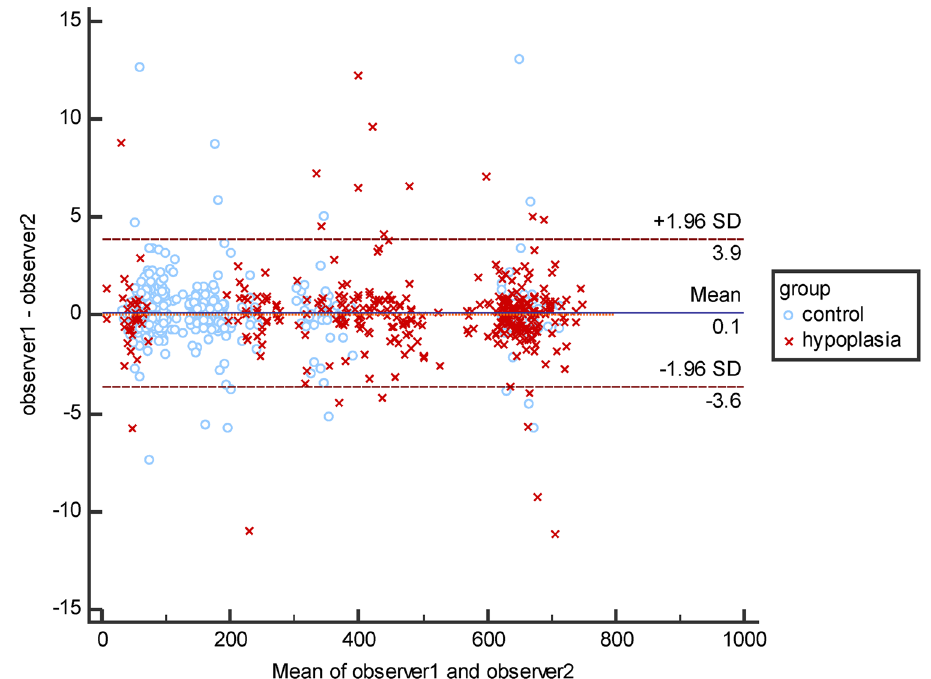
Figure 4. Bland–Altman plot for evaluating inter-rater